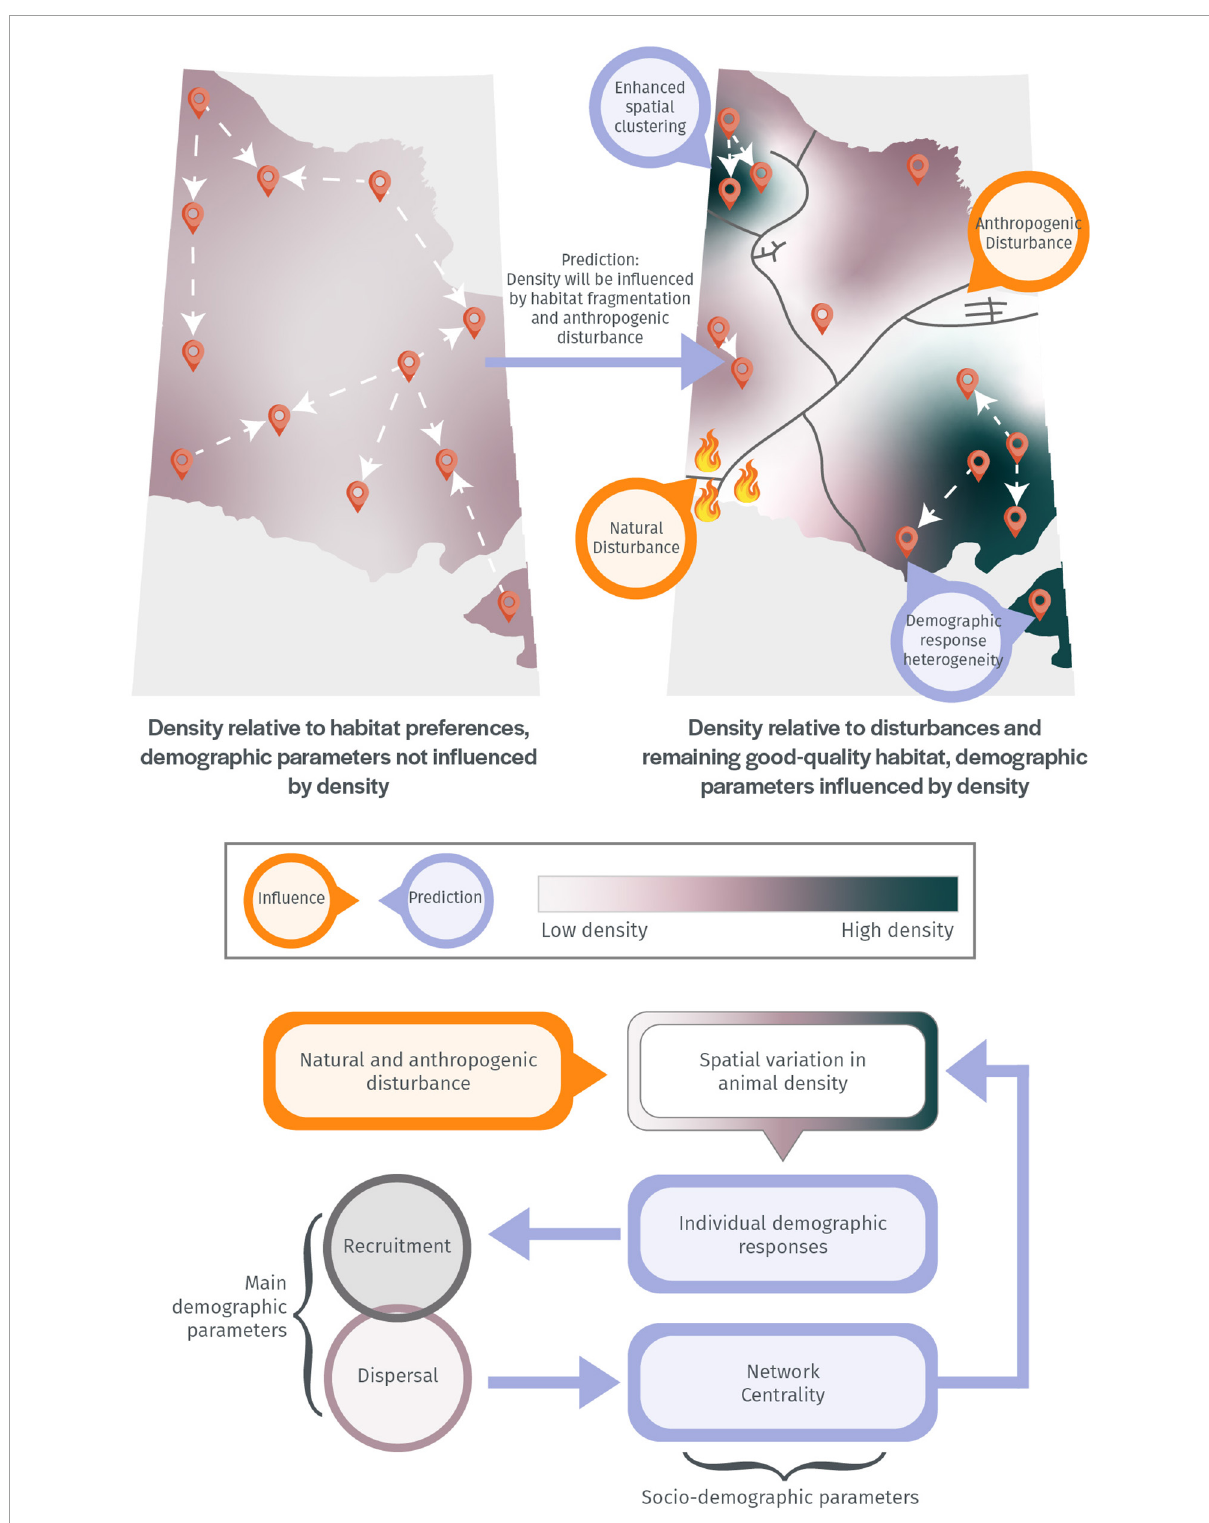
FIGURE1 The effects of variable spatial density on demographic parameters. Points on the map represent individuals, and arrows represent the direction of movement of individuals.